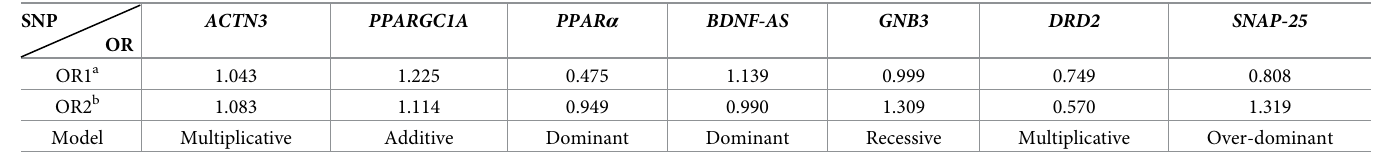
Table 1. Model adjustment according to examined SNPs.